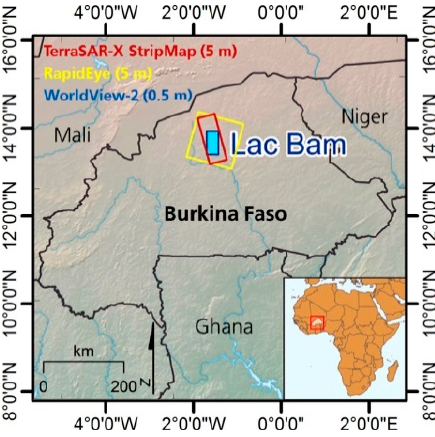
Figure 1. Study area: Lac Bam in Burkina Faso, West Africa, and footprint of the used datasets: TerraSAR-X (dark red), RapidEye (yellow), and WorldView-2 (blue).